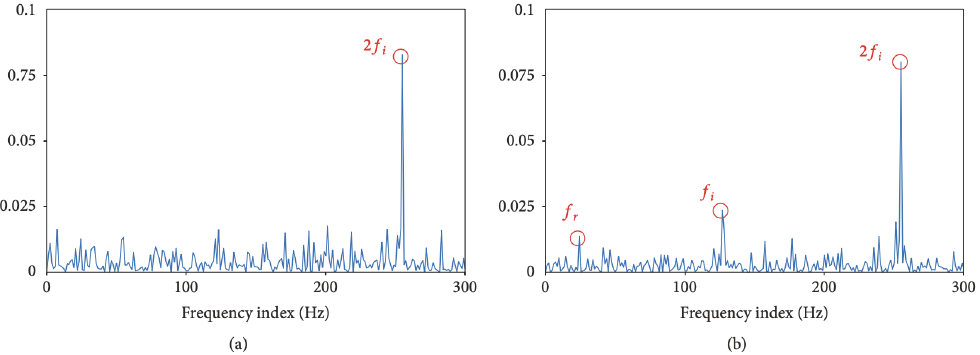
Figure 28. ( a ) Denoised signal by standard LP denoising method, ( b ) Frequency domain plot of denoised signal by AHLP denoising method